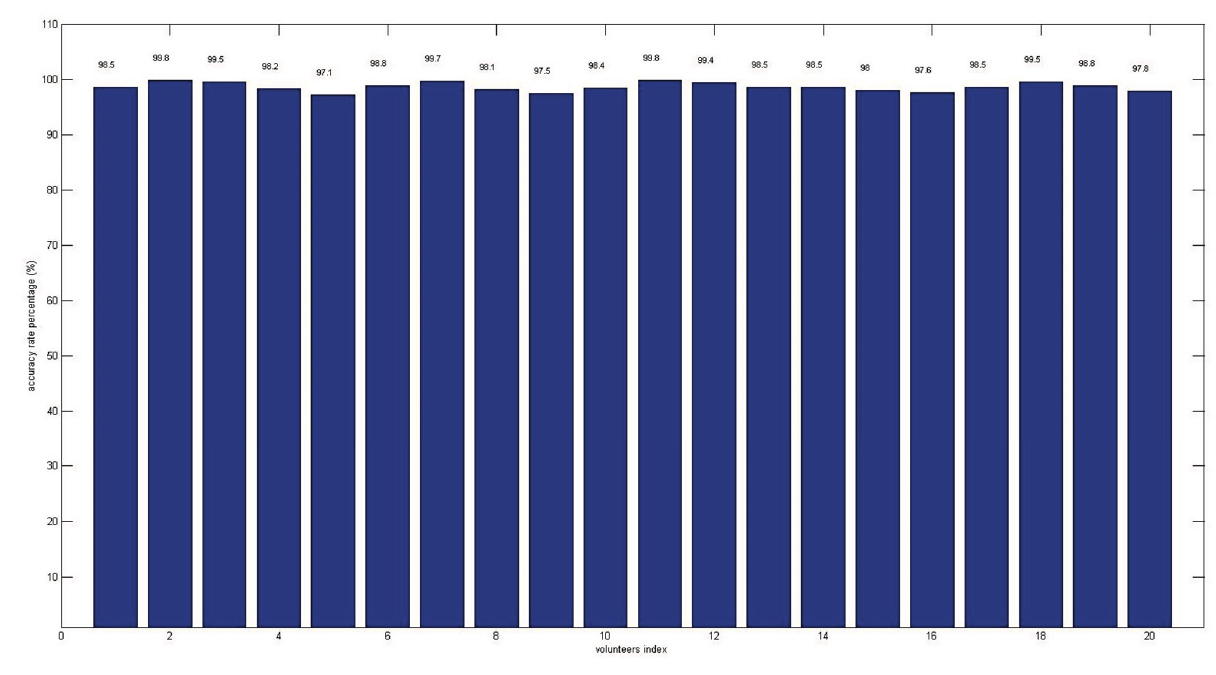
Figure 7. Accuracy rate of the SVM classifier corresponding to the twelve features (optimum) used to predict the driver awareness level for each